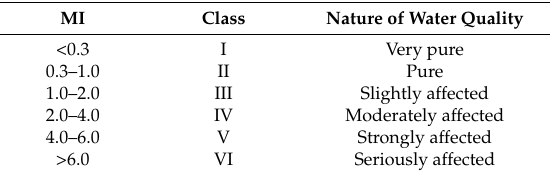
Table 3. Classification of water quality based on the Metal Index (MI) 1 . MI